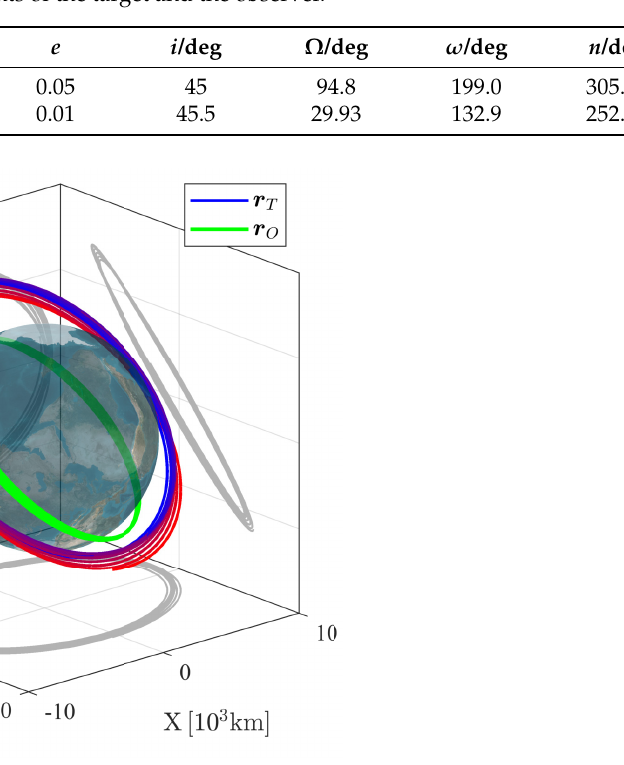
Figure 1. Illustration of the nominal orbits of the target and the observer. The orbit is colored by red at the beginning and gradually changes to blue at the end. The grey lines represent the projection of the nominal